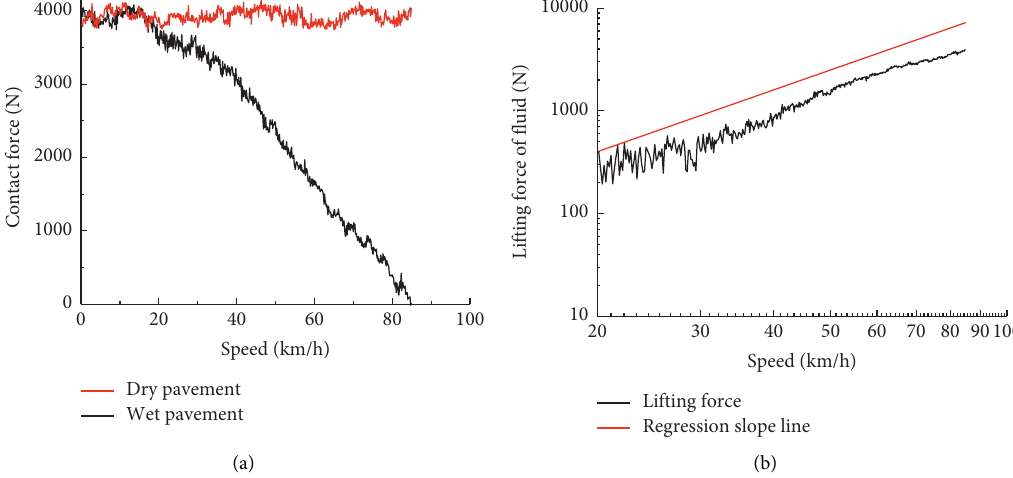
Figure 7: Comparison of vertical contact force on dry and wet roads. (a) Contact force curve of tire and pavement. (b) Fluid lifting force varying with speed.